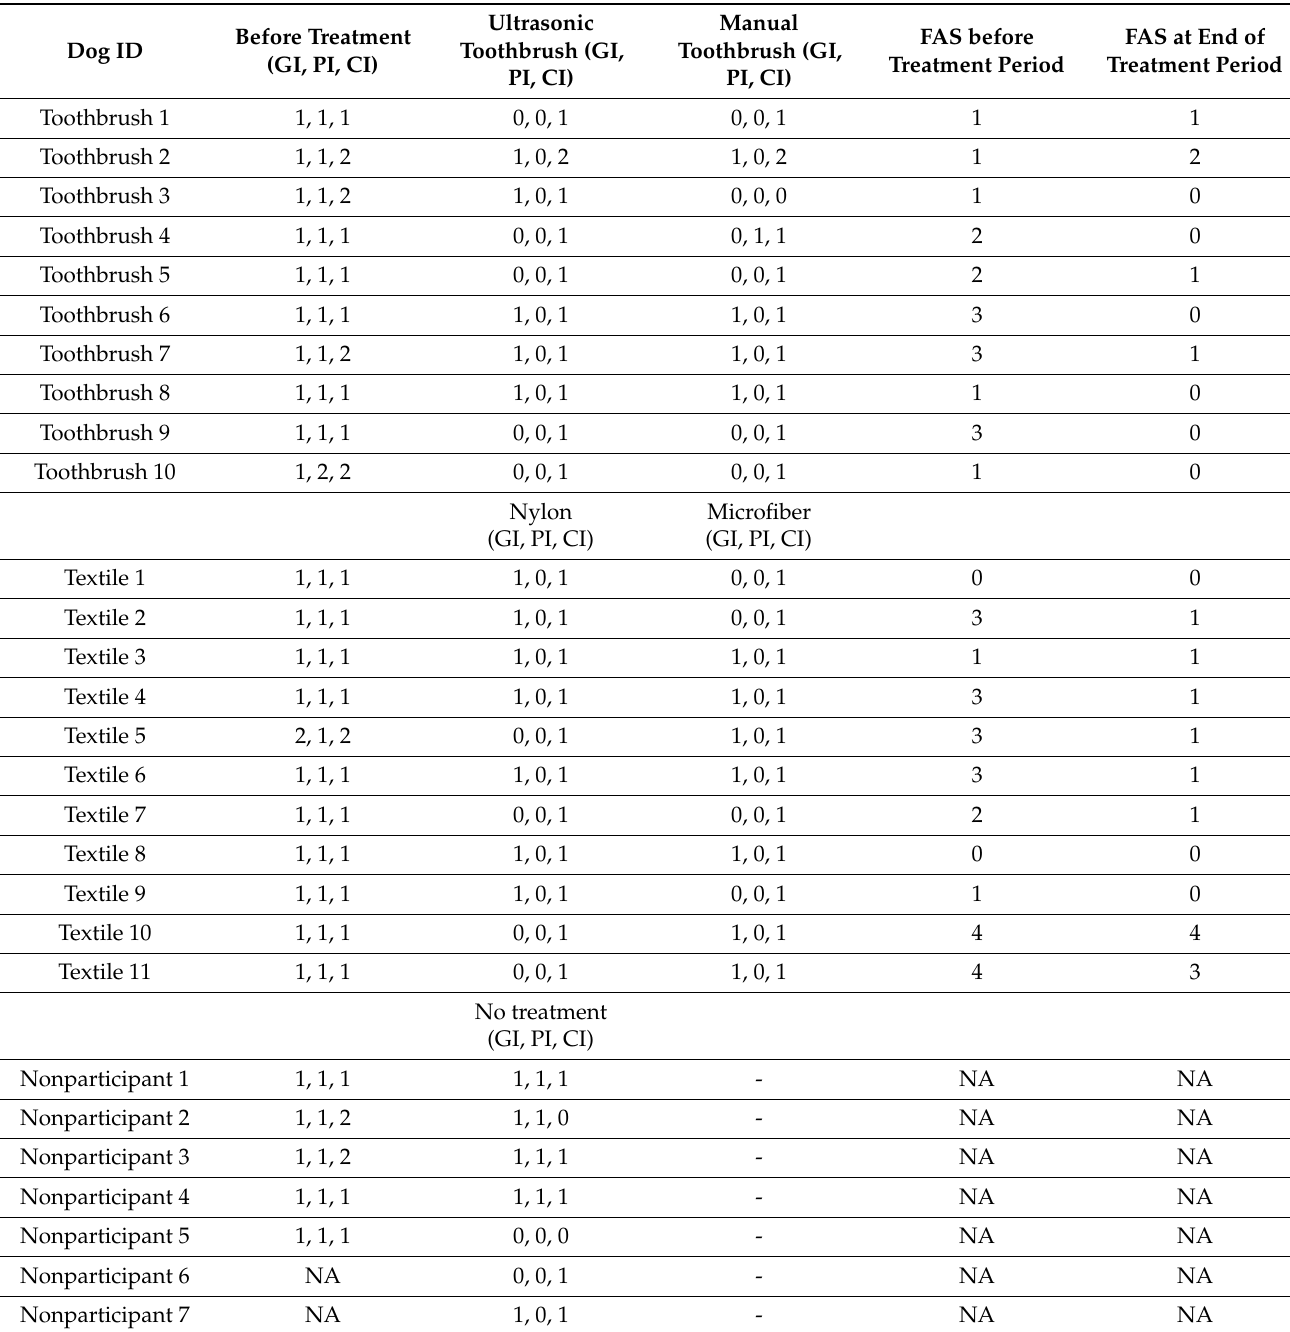
Table 4. Individual scores for gingiva index (GI), plaque index (PI) and calculus index (CI) and FAS score at the beginning and end of 35 days of daily dental cleaning (no cleaning for nonparticipant